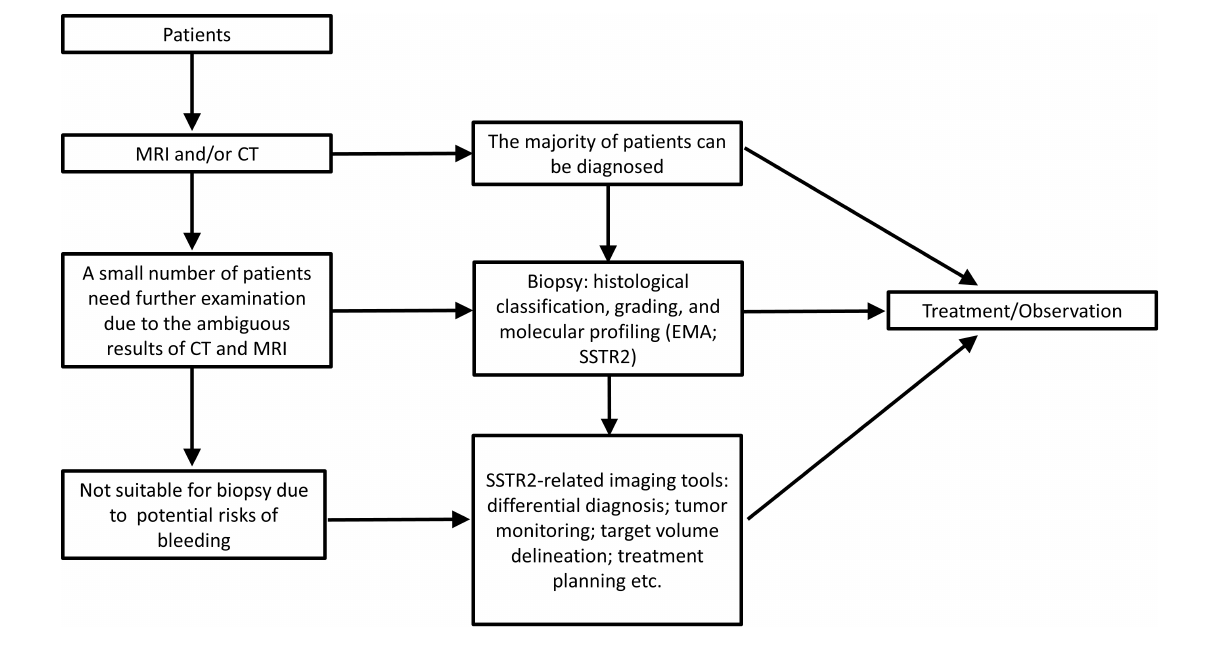
FIGURE 1 | The diagnosis process and application scenarios of meningioma with the utilization of